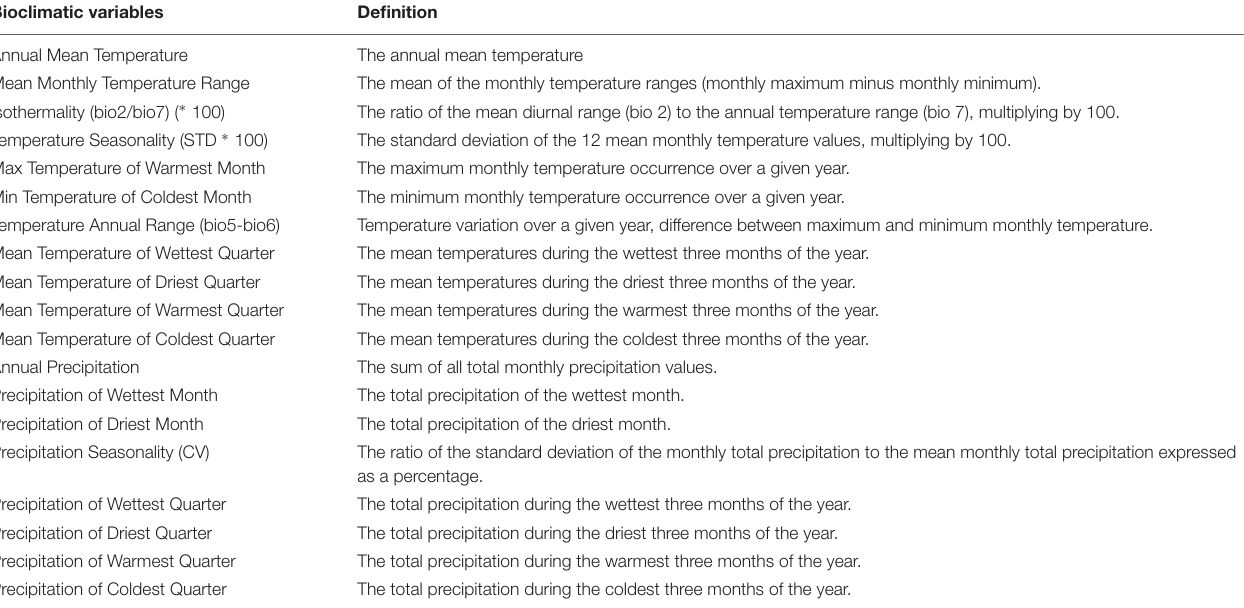
TABLE 2 | Mathematical definition of bioclimatic indices.